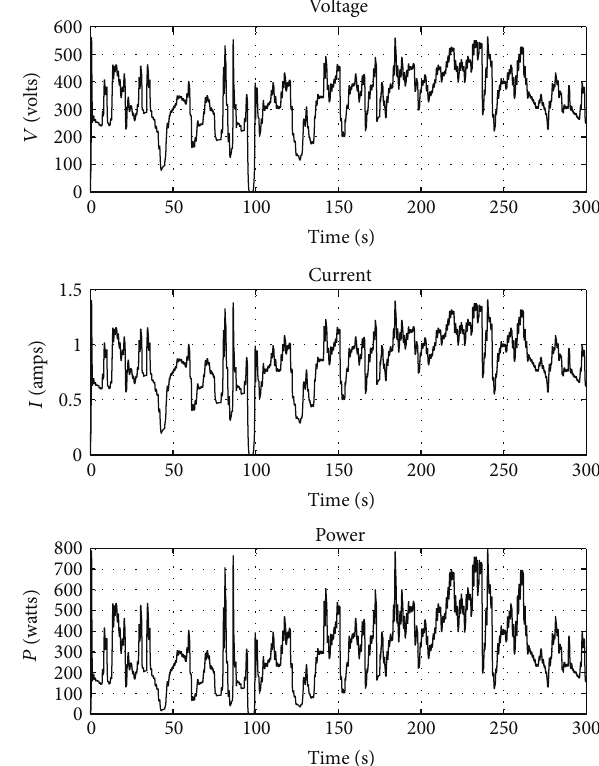
Figure 15: Voltage, current, and power output of WTG with MPPT controller.